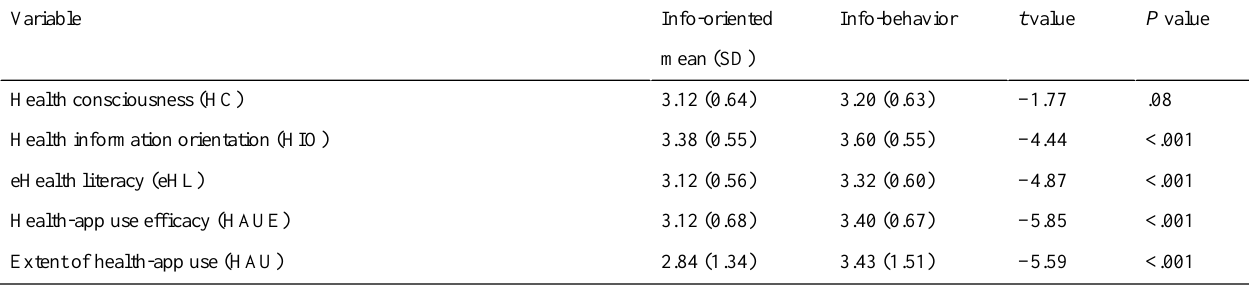
Table 1. Results for independent samples t test between information-oriented and information-behavior